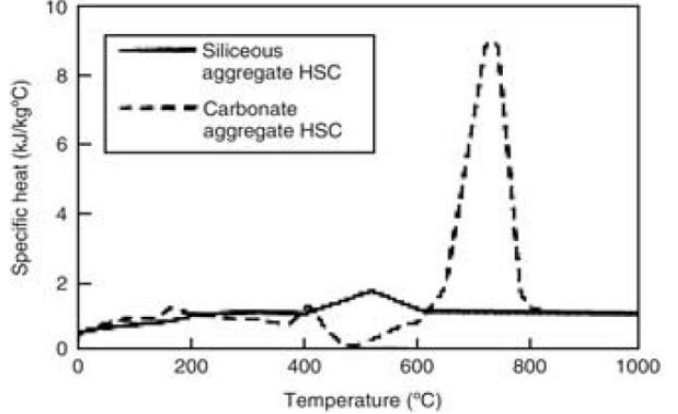
Figure 6. Specific heat of HSC [7]